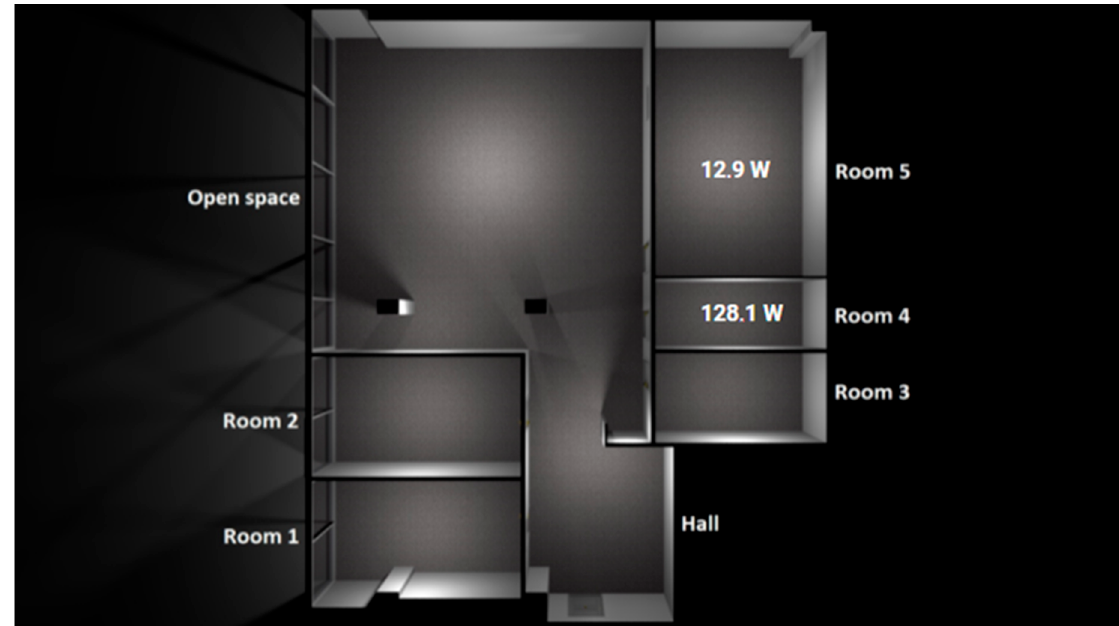
Figure 17. Graphical panel designed by CBRTI Sp. z o.o. Research and Development Center showing the current energy consumption with a breakdown by room.